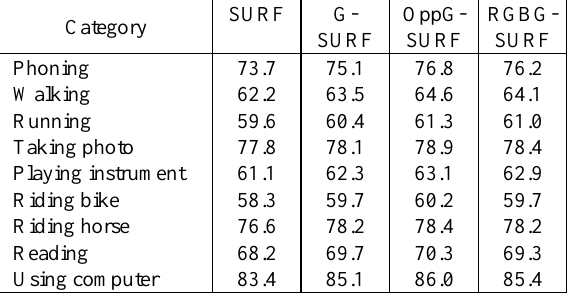
Table 1. Precision results for nine action categories